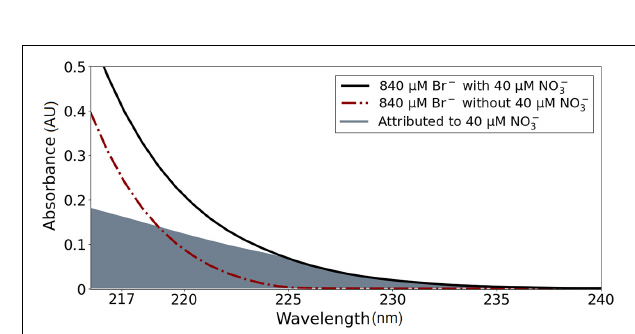
FIGURE 7 | The spectral signature of calibration solutions at 20 ◦ C. The gray filled area is attributed to absorbance due to NO 3 − .